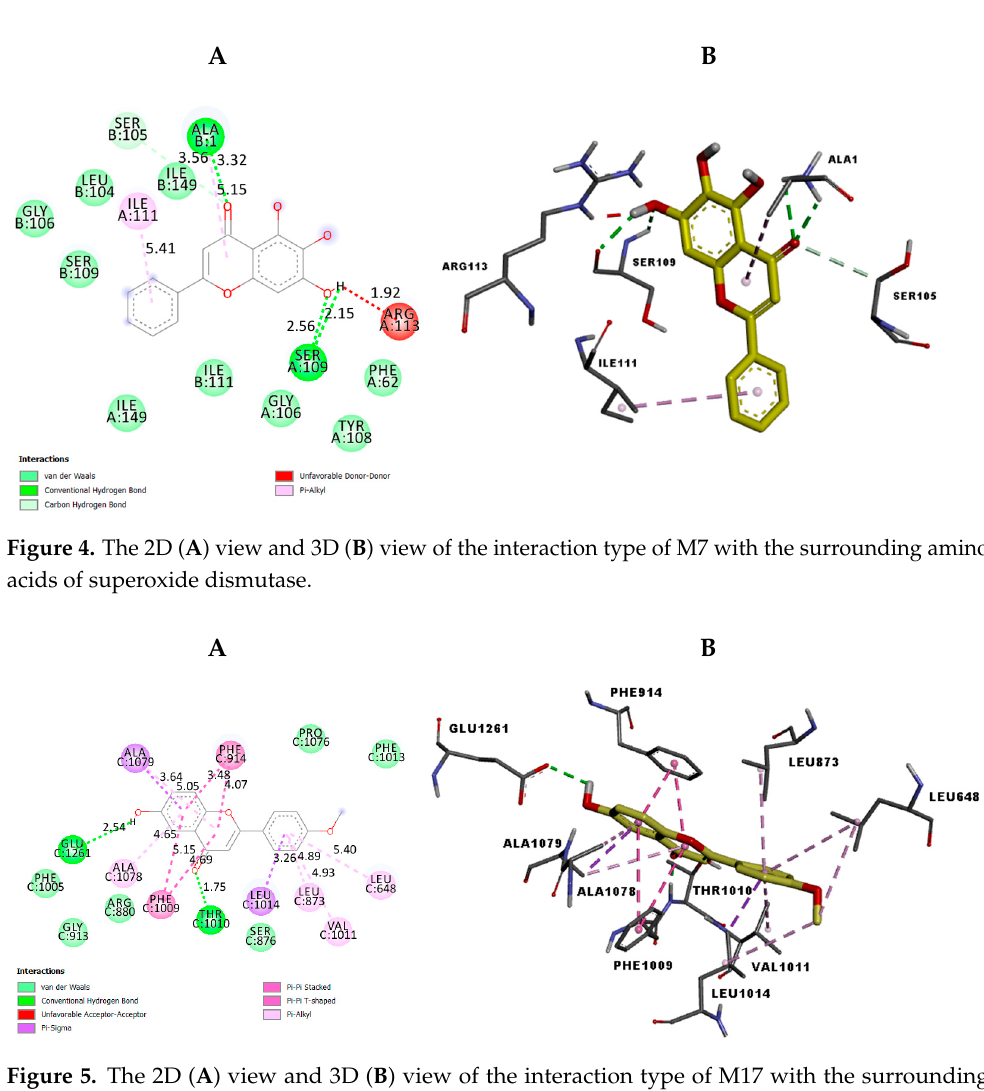
Figure 3. The 2D ( A ) view and 3D ( B ) view of the interaction type of M7 with the surrounding amino acids of acetylcholinesterase.